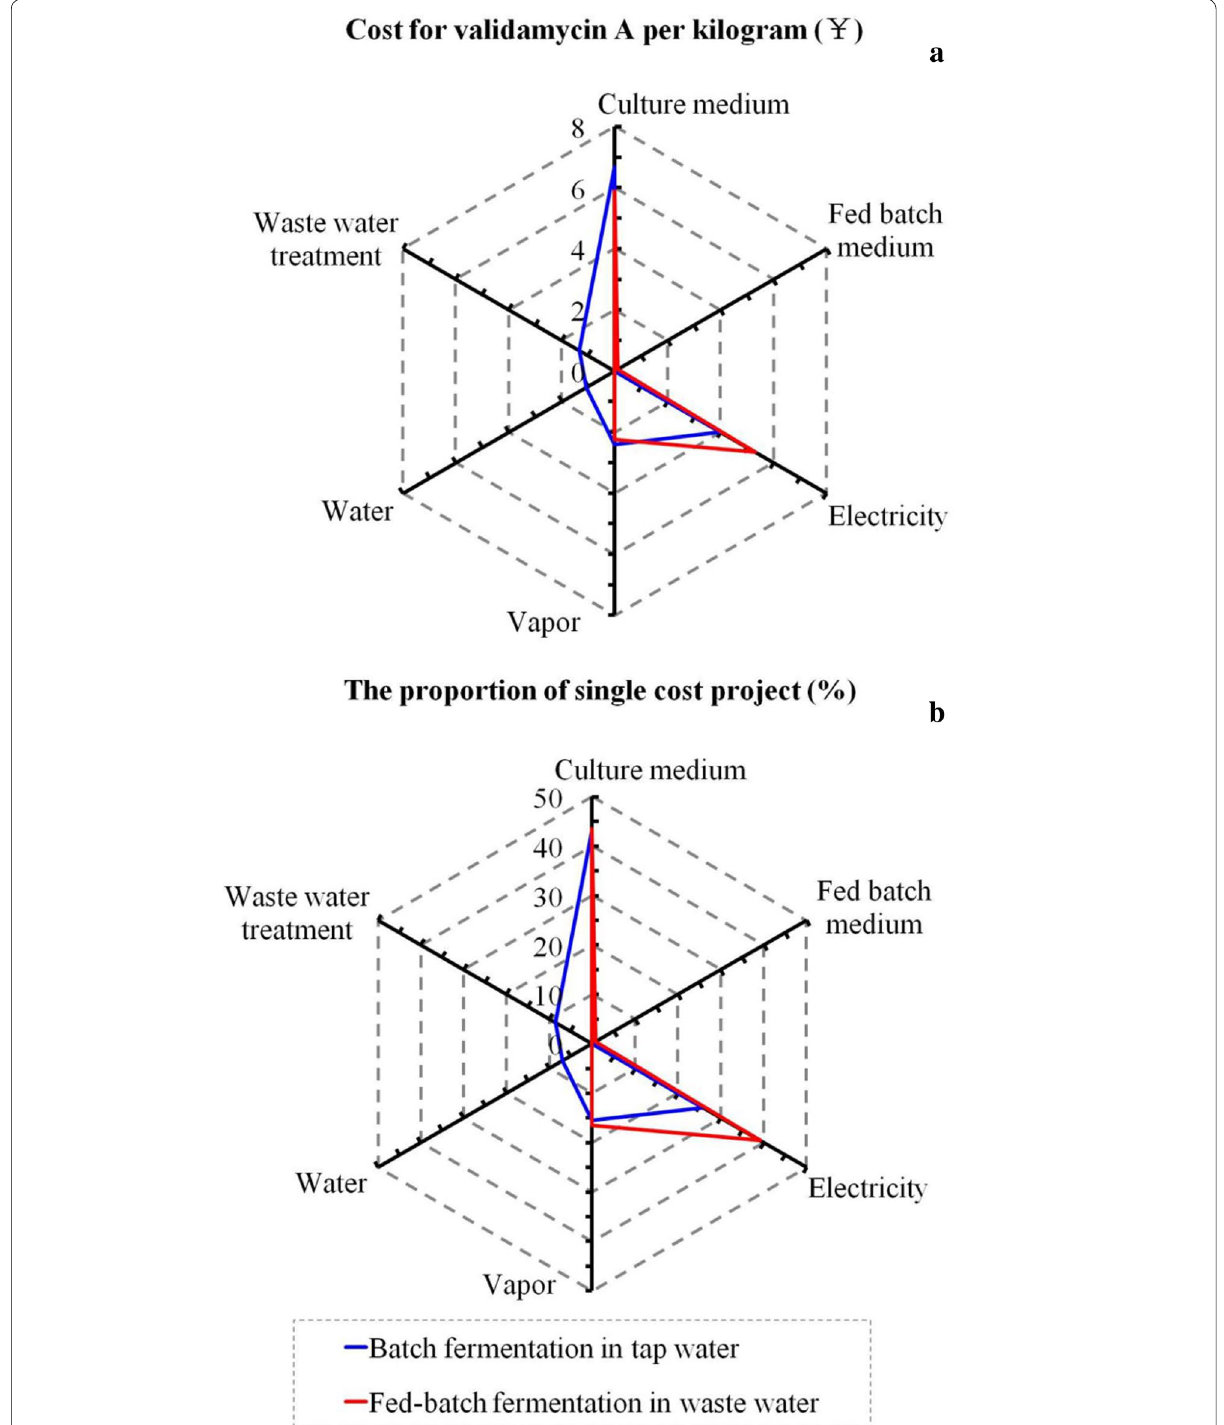
Fig. 4 The radar maps of production cost for validamycin A per gram ( a ) and proportion of single cost factor ( b ). Blue line indicates the batch fermentation in tap water by K18, red line indicates the fed-batch fermentation in ion-exchange wastewater by